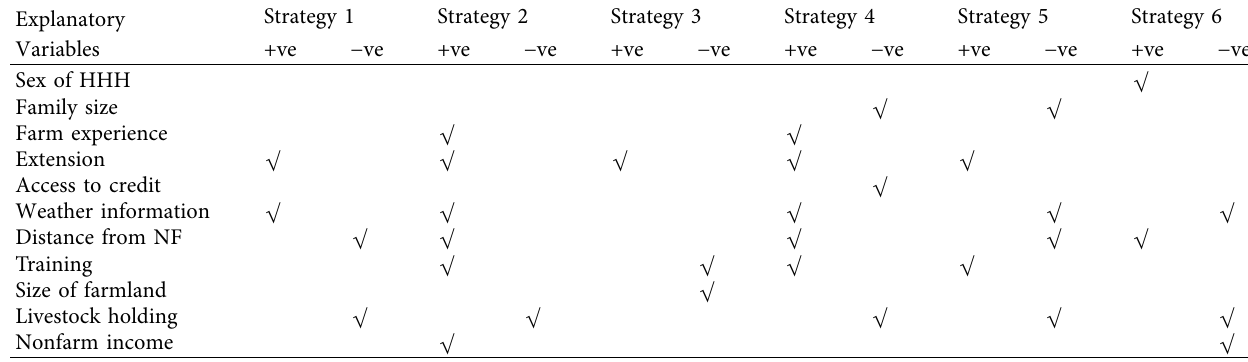
Table 6: Summaries of the explanatory variables with adaptation